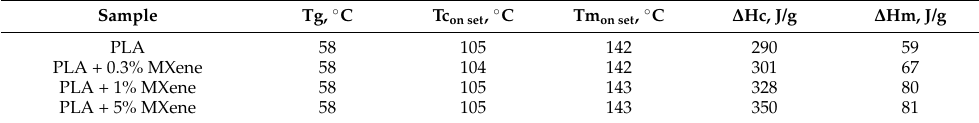
Table 1. Results obtained from the calorimetric analysis of the PLA and composites.